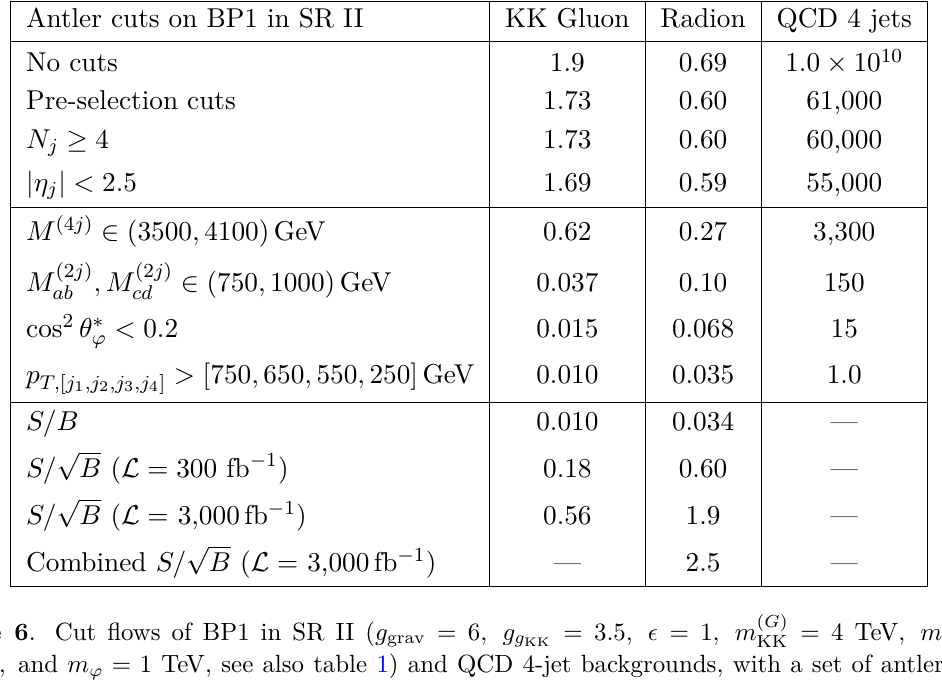
Table 6 . Cut flows of BP1 in SR II ( g grav = 6 , g g 3 TeV , and m ϕ = 1 TeV , see also table 1) and QCD 4-jet backgrounds, with a set of antler cuts. The same explanations including the pre-selection cuts as in the caption of table 4 are applicable.